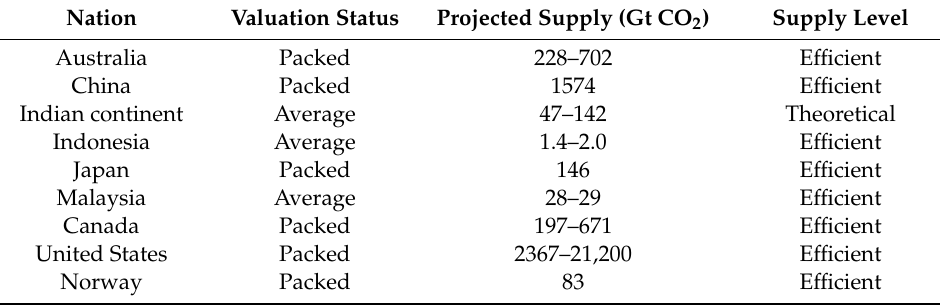
Table 7. World-wide storage portfolio assessment [46].